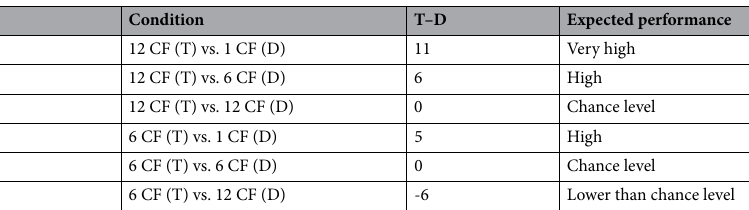
Table 1. Our six hypotheses. In the left and middle column of the table, T corresponds to Target and D corresponds to Distractor. The middle column represents the difference in contrast features between the target and the distractor. Each condition indicates a different number of correct contrast feature for the targets and the distractors.